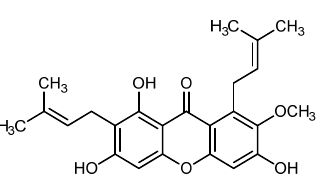
Figure 1. The chemical structure of mangostin.